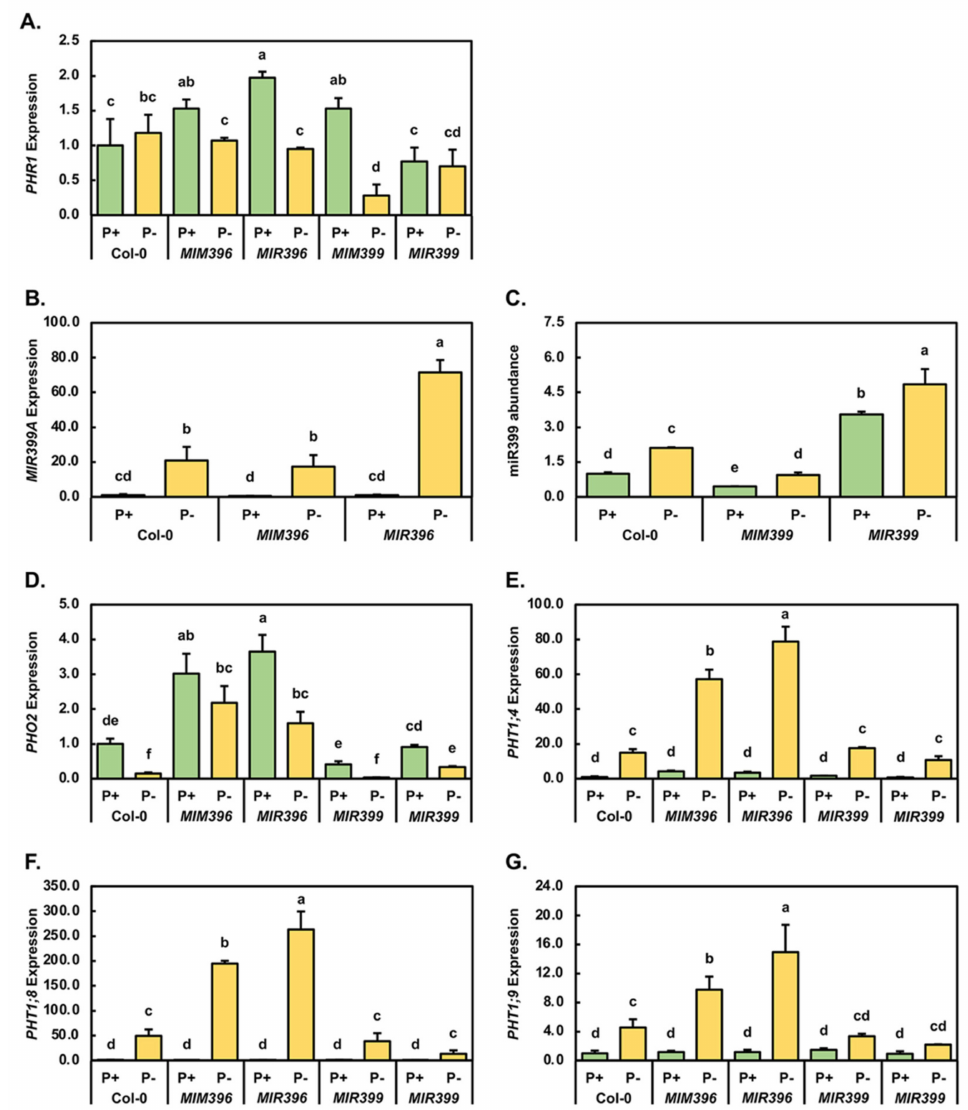
Figure 4. Molecular profiling of upstream and downstream components of the miR399/ PHO2 expression module in 15-day-old control-grown and PO 4 -starved Col-0, MIM396 , MIR396 , MIM399 and MIR399 seedlings. RT-qPCR quantification of PHR1 expression ( A ), MIR399A gene expression ( B ), miR399 abundance ( C ), PHO2 expression ( D ) and the level of gene expression of the PO 4 transporters, PHT1;4 ( E ), PHT1;8 ( F ) and PHT1;9 ( G ) in Col-0/P + , Col-0/P - , MIM396 /P + , MIM396 /P - , MIR396 /P + , MIR396 /P - , MIM399 /P + , MIM399 /P - , MIR399 /P + and MIR399 /P - seedlings. ( A – G ) The error bars above histogram columns represent the standard deviation of four biological replicates and all statistical data were analyzed using the one-way ANOVA and Tukey’s post hoc tests. A different letter above a histogram column represents a statistically significant difference ( p -value <